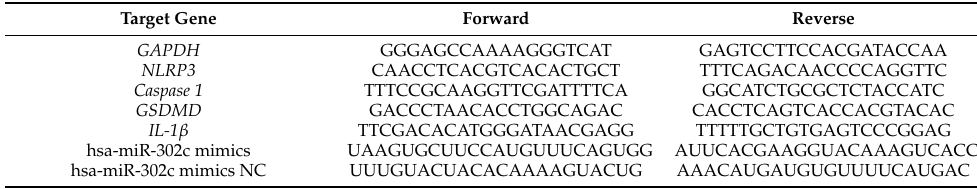
Table 2. The primer sequence of target